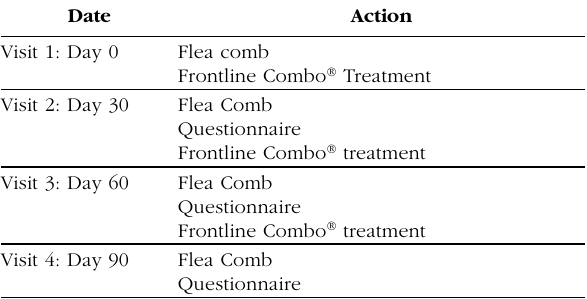
Table II. – Design of the three month